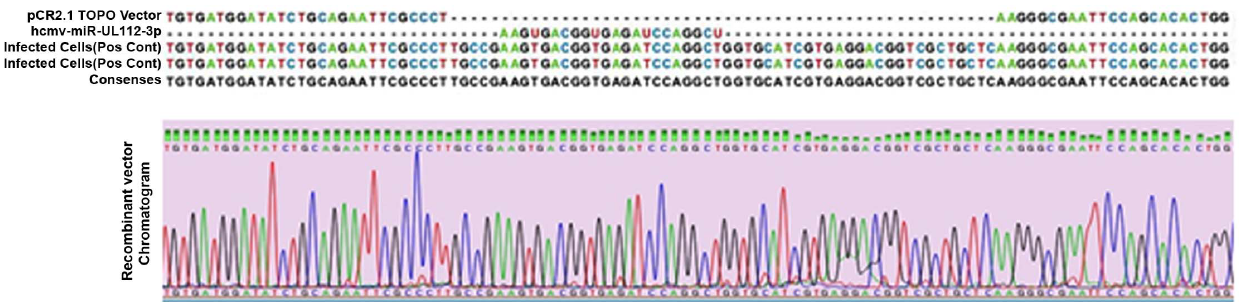
Figure 1. Confirmation of a cloned hcmv-miRUL112-3p TaqMan PCR amplicon from in vitro infected HCMV lung fibroblasts (Positive Control): Alignment of sequences (from above) shows the PCR2.1 TOPO empty plasmid, hcmv-miR-UL112 sequence from miRBase database and last two sequences confirms the PCR product was inserted into the PCR2.1 TOPO plasmid. The lower part represents the chromatogram for the recombinant plasmid.